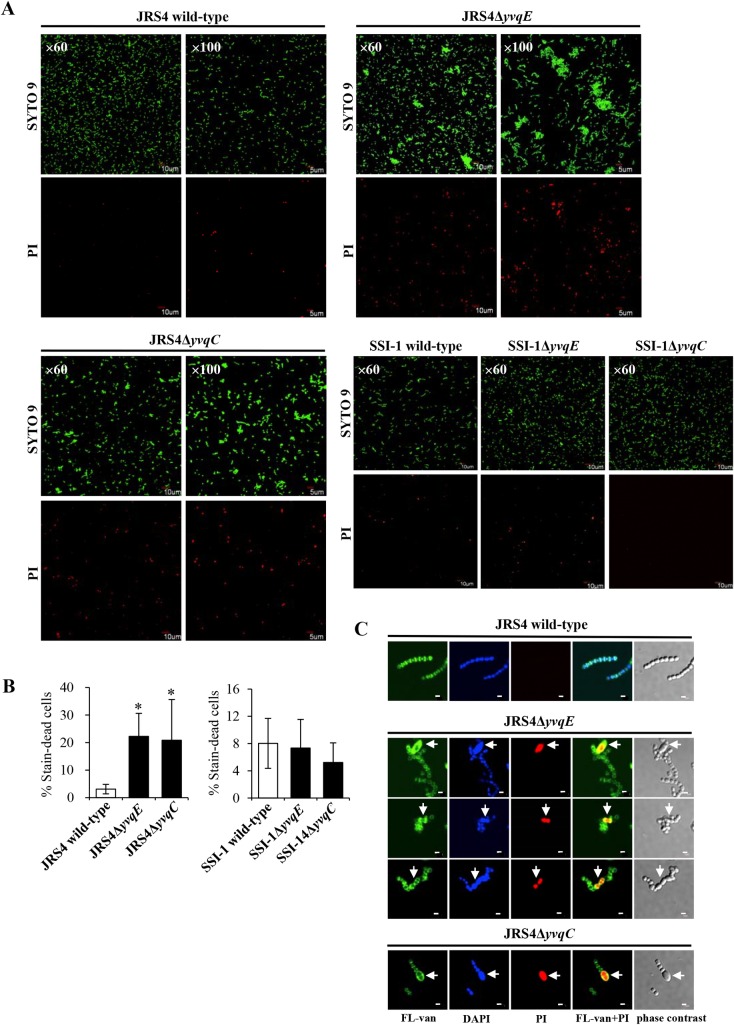
Deletion of yvqE and yvqC in JRS4 results in reduced viability.(A) Representative images of LIVE/DEAD-stained wild-type JRS4, JRS4ΔyvqE, JRS4ΔyvqC, wild-type SSI-1, SSI-1ΔyvqE, and SSI-1ΔyvqC grown in THY at an OD600 of 0.8. Live bacteria are stained green (SYTO 9) and dead bacteria are stained red (PI). Magnification, ×60 and ×100. (B) The percentage of dead cells in ΔyvqE and ΔyvqC strains was compared with wild-type. Data were expressed as the mean and standard deviation. Asterisks indicate statistically significant difference at P < 0.05 (*). (C) Representative images of wild-type JRS4, JRS4ΔyvqE, and JRS4ΔyvqC grown in THY at an OD600 of 0.8. Septum and cell wall of bacteria are stained green (FL-van), dead bacteria are stained red (PI), and nuclei of bacteria are stained blue (DAPI). Scale bars represent 1 μm. Arrows indicate defects in cell division.